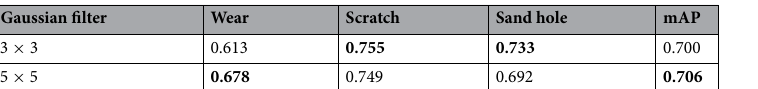
Table 3. Performance of Swin Transformer with Gaussian filters on three classes, where we compare the results under the filter sizes of 3 × 3 and 5 × 5 . The best result is in